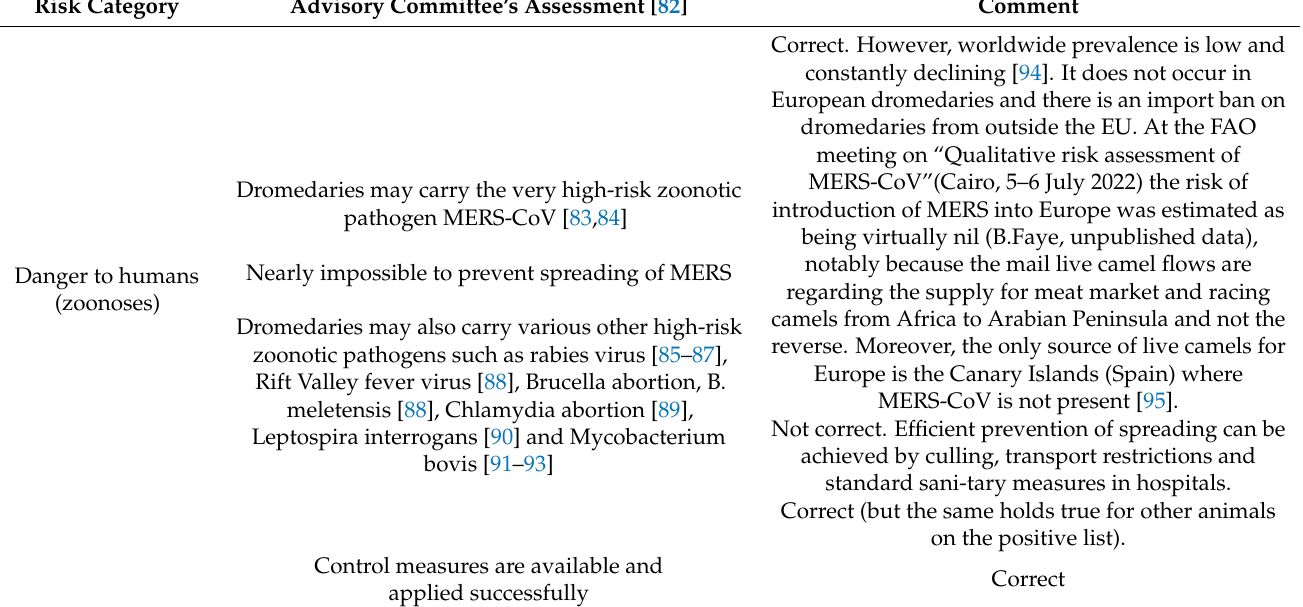
Table 2. Summary of comments on the advisory committee’ assessment of risk categories that the dromedary poses for human and animal safety and